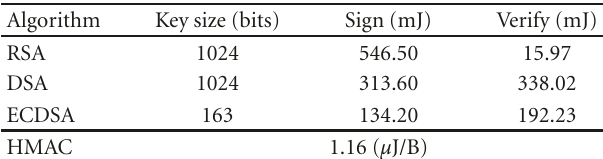
Table 2: Energy cost of digital signature algorithmsand HMAC, for Compaq iPAQ H3670